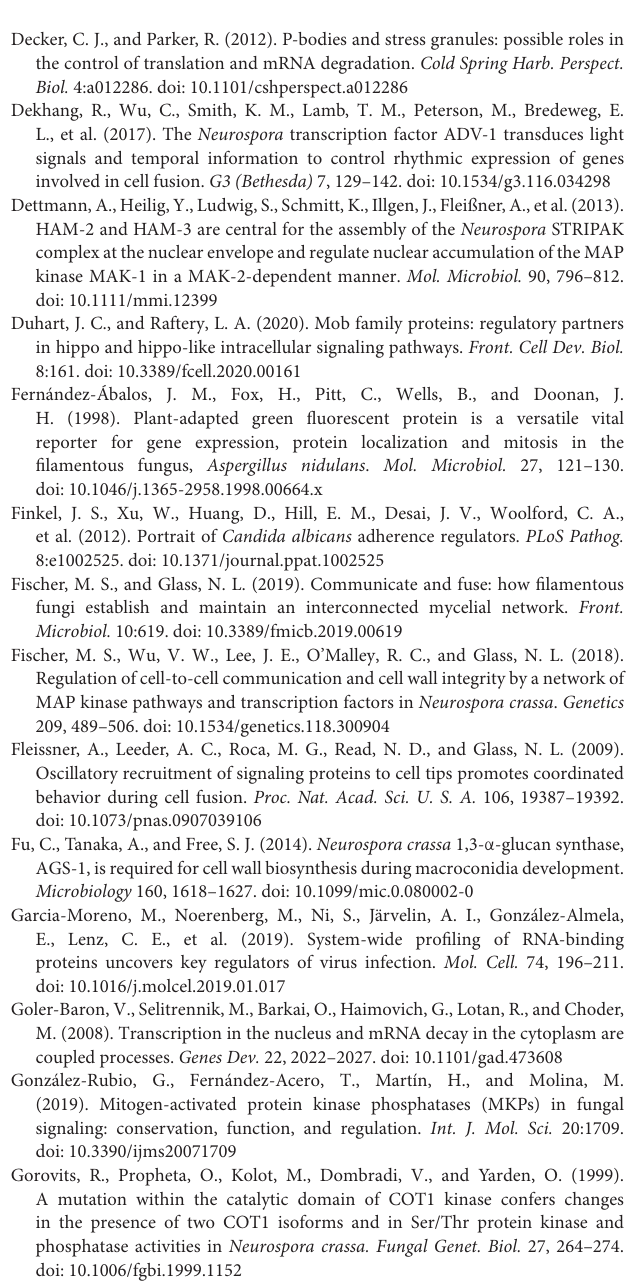
Supplementary Table 1 | Sequence data summary. Supplementary Table 2 | RNASeq gene count. Supplementary Table 3 | N. crassa transcripts containing the complete or one mismatch of the yeast Ssd1-binding 5’ UTR motif. Supplementary Table 4 | N. crassa RNA species that interact with